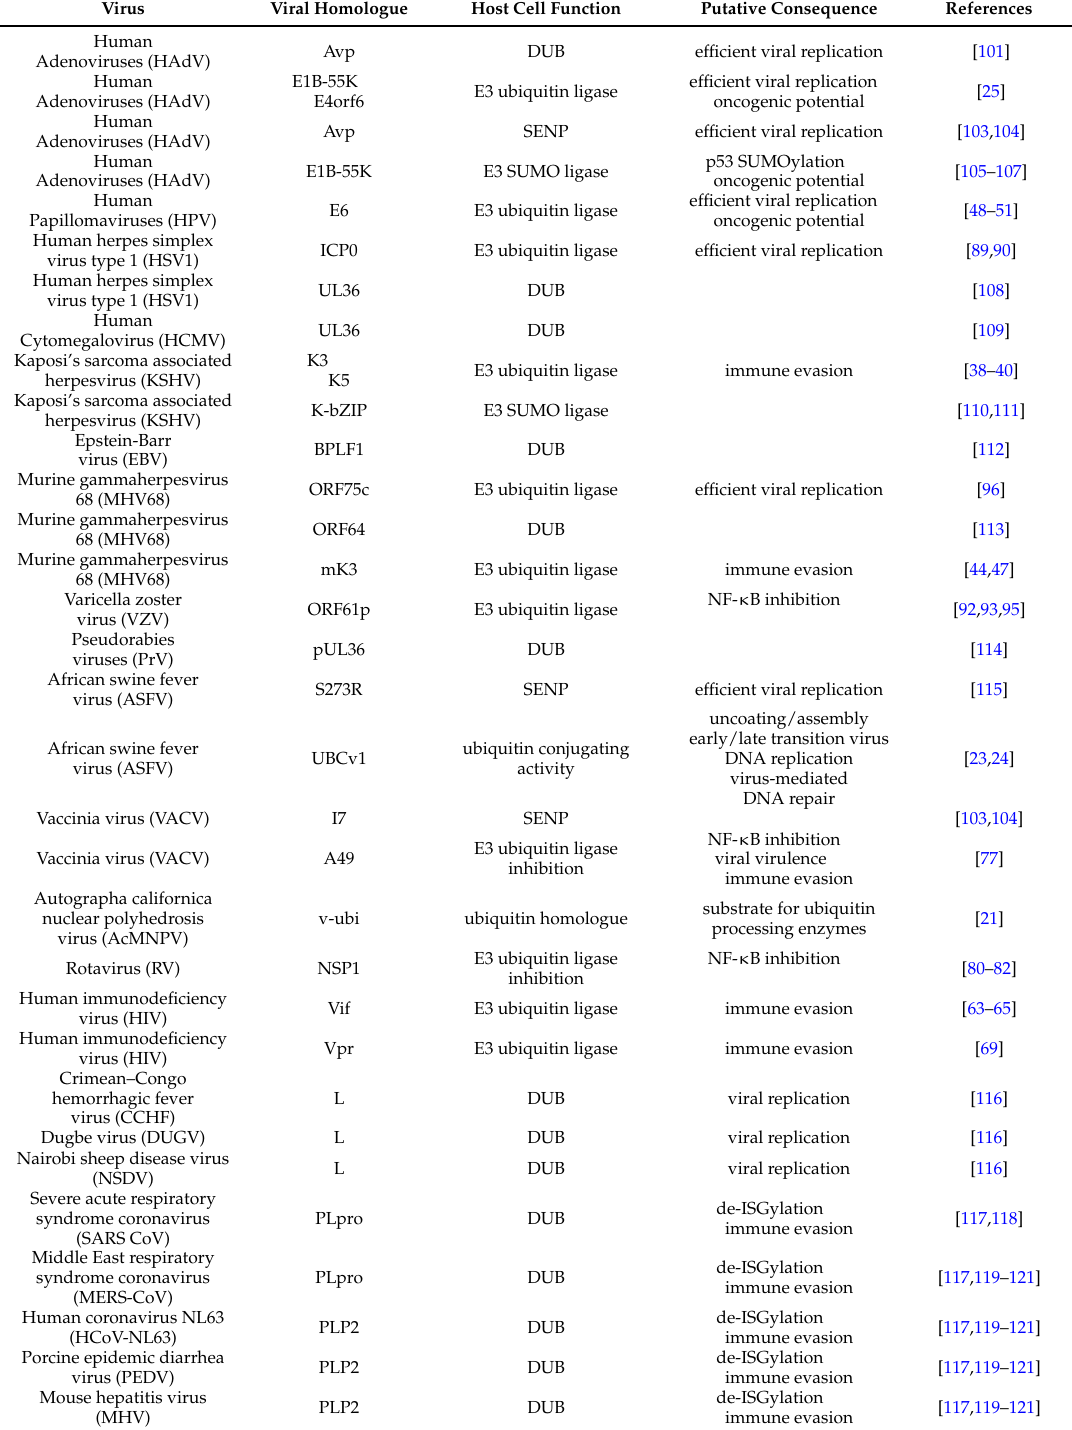
Table 1. Host cell SUMO/Ubiquitin processes infiltrated by viral